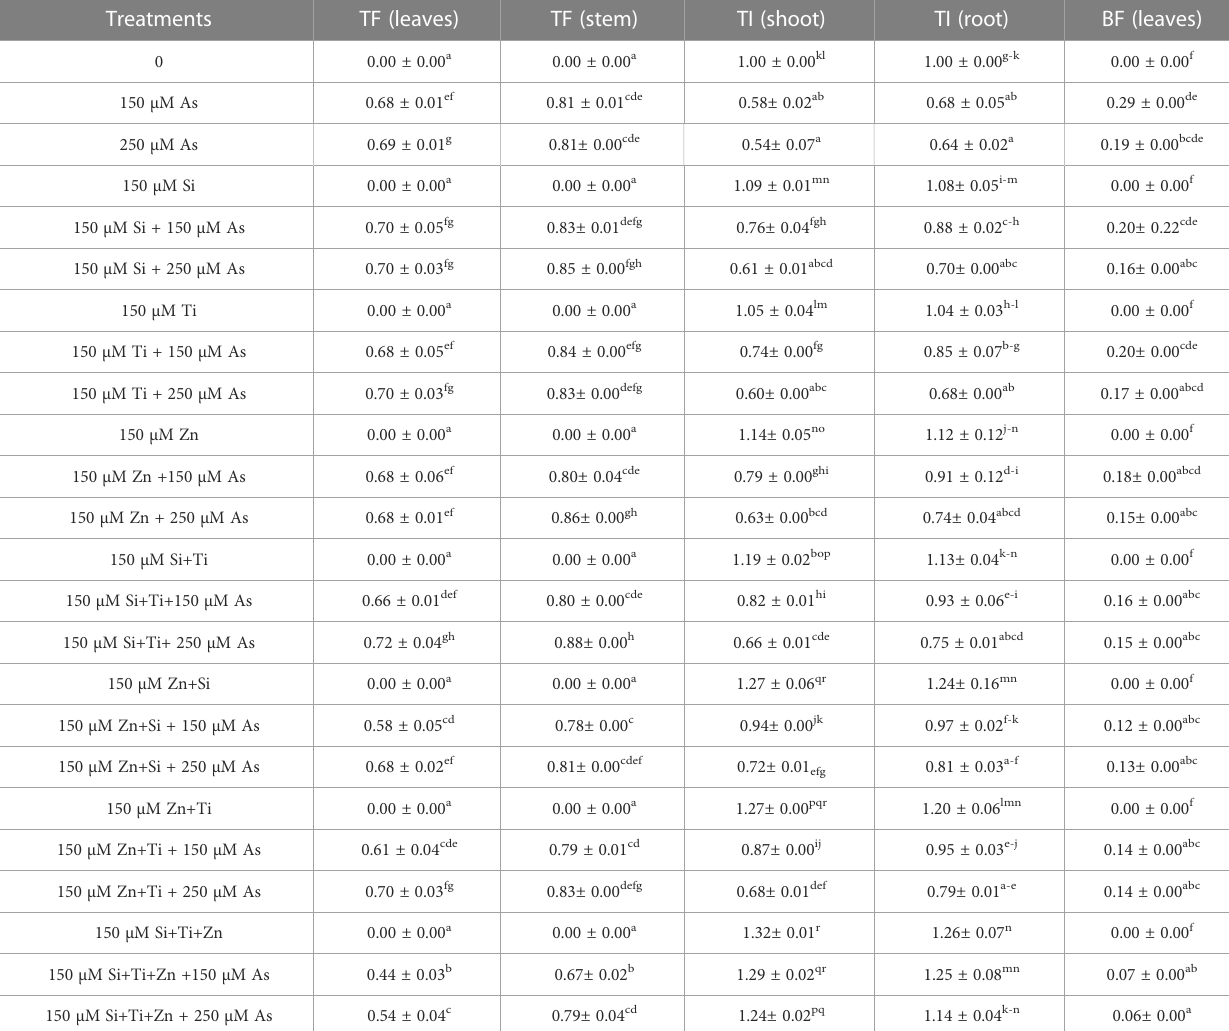
TABLE 2 Changes in the translocation factor (TF) of bamboo leaves and stem, tolerance index (TI) of shoot and root, as well as bioaccumulation factor (BF) of leaves in response to 150 µM NPs in combination or single form when exposed to 150 µM and 250 µM As, compared to the control